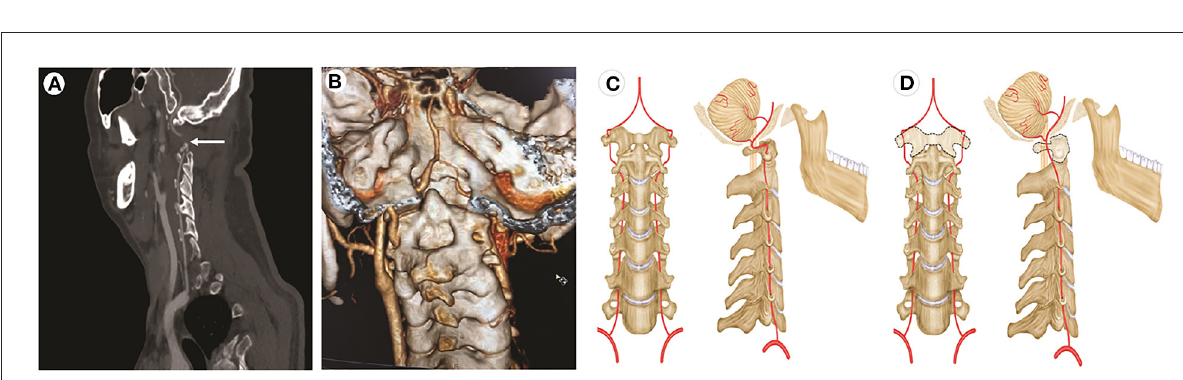
FIGURE2 CT angiography and illustrations of normal VA and potential cause of BHS involving occipitalization of the atlas. (A) A contrast agent is not filling the local area of the right vertebral artery (arrow) with the patient’s head turned left. (B) CT angiography reveals occipitalization of the atlas (C1) and congenital agenesis of the posterior elements of the atlas (C1). (C) Normal movement of the VA. (D) The dotted line shows the dysplastic